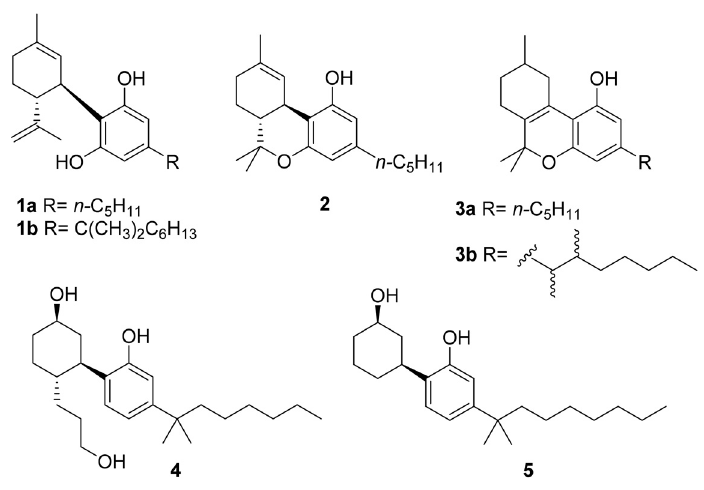
Figure 1. Structures of CBD ( 1a ), its α , α -dimethylheptyl analogue ( 1b ), ∆ 9 -THC (2), ∆ 6a , 10a THC ( 3a ), pyrahexyl ( 3b ), CP-55.940 ( 4 ), and cannabicyclohexanol ( 5